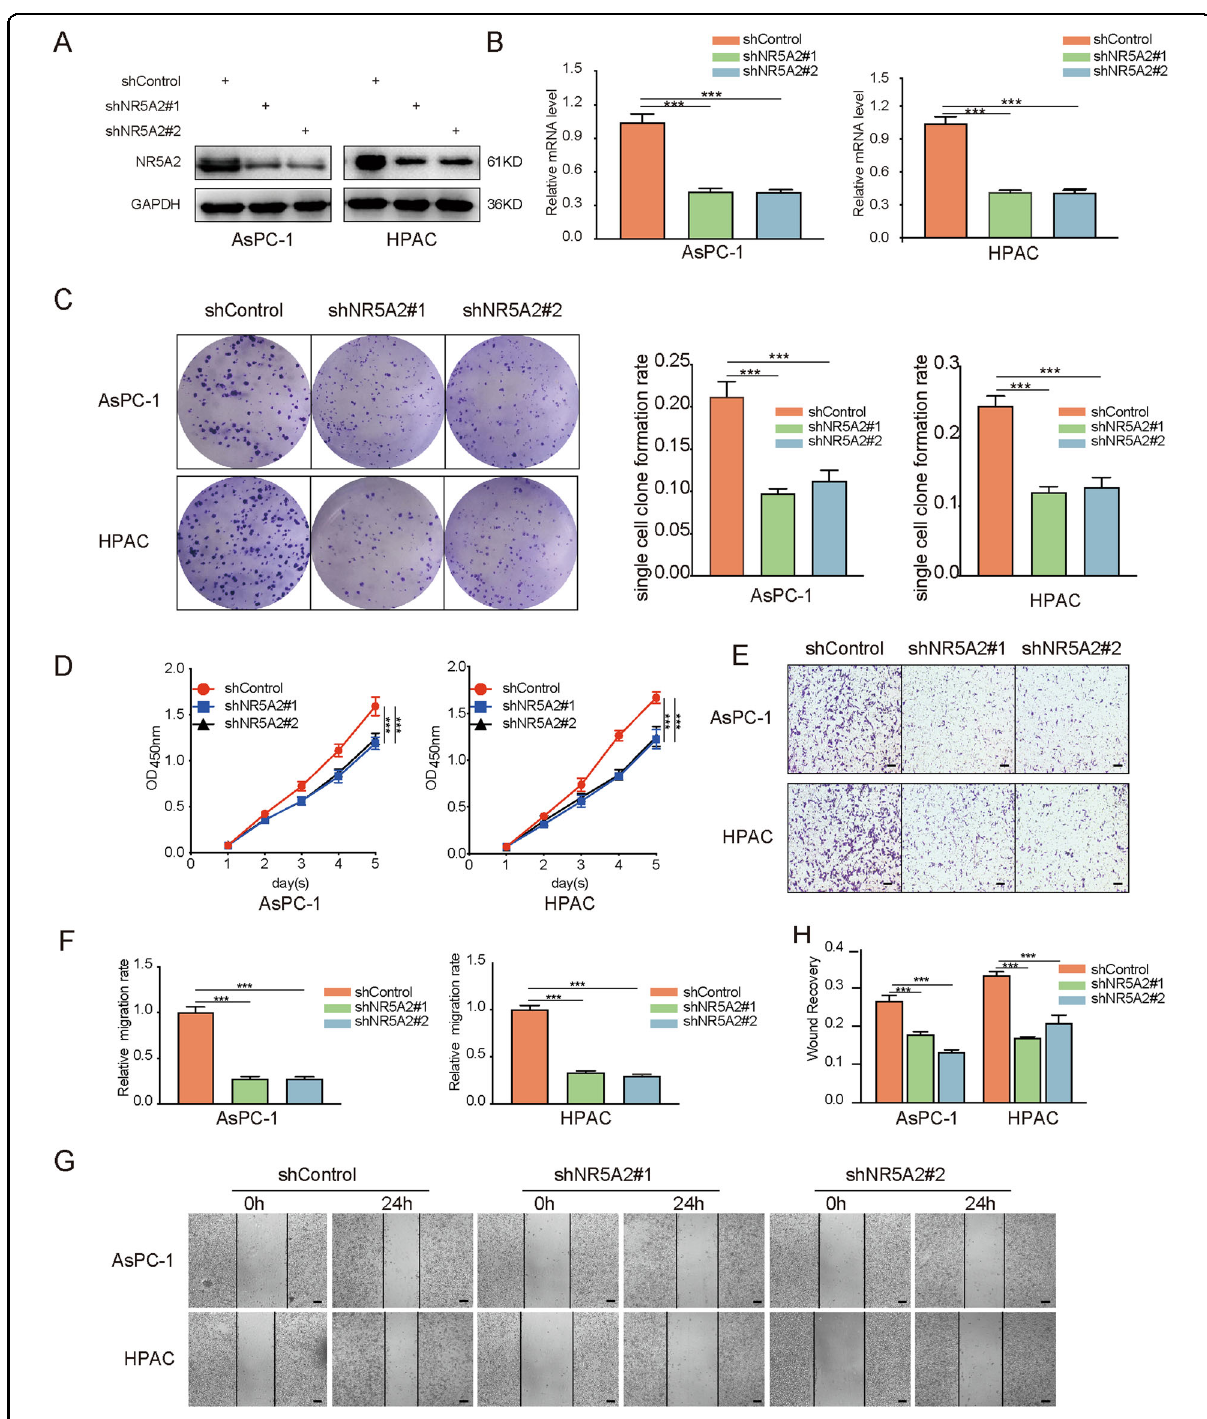
Fig. 2 Silencing NR5A2 suppressed potential malignancy of pancreatic cancer cells. A , B Western blot analysis ( A ) and RT-qPCR ( B ) to show the NR5A2 expression in AsPC-1 and HPAC cells infected with lentivirus vectors expressing control or NR5A2 speci fi c shRNAs. GAPDH served as an internal reference. Data presented as the mean ± SD of three independent experiments. Statistical signi fi cance was determined using one-way ANOVA. C – H AsPC-1 and HPAC cells infected with lentivirus vectors expressing control or NR5A2 speci fi c shRNAs were harvested for colony formation assay ( C ), MTS assay ( D , n = 5), transwell invasion assay ( E , F ), and wound-healing assay ( G , H ), scale bars: 100 μ m. Each bar represents the mean ± SD of three independent experiments. *** P < 0.001, one-way ANOVA.